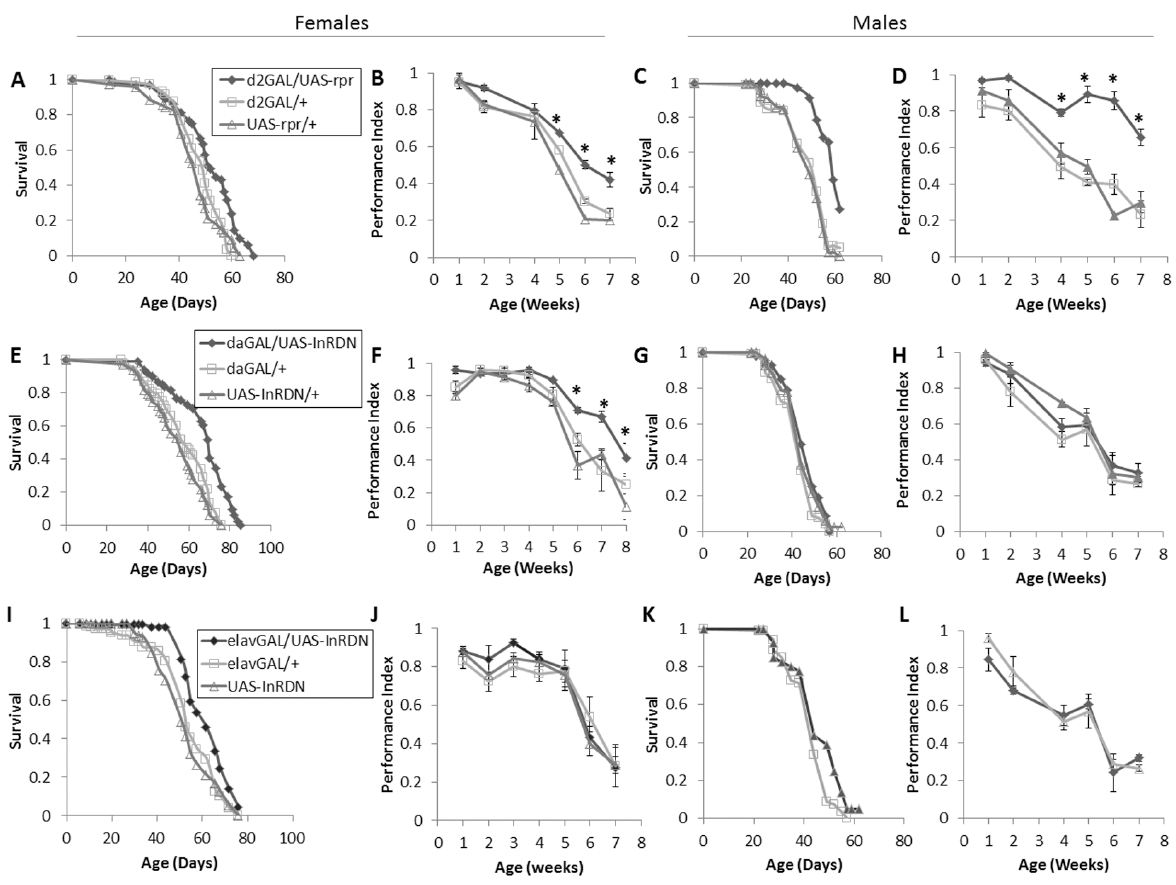
Fig 1. Survival and negative geotaxis senescence in female flies with ubiquitous (d2GAL/UAS-rpr and daGAL4/UAS-InR DN ) or neuron specific (elavGAL4/UAS-InR DN ) reductions in IIS. (A) Survival of d2GAL/UAS-rpr once mated female flies compared to d2GAL/+ and UAS-rpr/+ controls. Median lifespans and sample sizes were: d2GAL/UAS-rpr = 51 days, N = 71; d2GAL/+ = 49 days, N = 117; and UAS-rpr/+ = 48 days, N = 69. d2GAL/UAS-rpr showed an increased survival compared to both controls by log rank tests (P = 0.001). ( B ) Negative geotaxis performance index (PI) over the lifespan of d2GAL/UAS-rpr once mated female flies compared to d2GAL/+ and UAS-rpr/+ controls, N = 3 (groups of 15 flies) for each genotype. (C) Survival of d2GAL/ UAS-rpr male flies compared to d2GAL/+ and UAS-rpr/+ controls. Median lifespans and sample sizes were: d2GAL/UAS-rpr = 58 days, N = 70; d2GAL/+ = 47 days, N = 80; and UAS-rpr/+ = 50 days, N = 80. d2GAL/UAS-rpr showed an increased survival compared to both controls by log rank tests (P < 0.0001). ( D ) Negative geotaxis performance index (PI) over the lifespan of d2GAL/UAS-rpr male flies compared to d2GAL/+ and UAS-rpr/+ controls, N = 3 (groups of 15 flies) for each genotype. ( E ) Survival of daGAL4/UAS-InR DN once mated female flies compared to daGAL4/+ and UAS-InR DN /+ controls. Median lifespans and sample sizes were: daGAL4/UAS-InR DN = 70 days, N = 81; daGAL4/+ = 59 days, N = 84; and UAS-InR DN /+ = 56 days, N = 97. daGAL4/UAS-InR DN showed an increased survival compared to both controls (P < 0.0001). ( F ) Negative geotaxis performance index (PI) over the lifespan of daGAL4/UAS-InR DN once mated female flies compared to daGAL4/+ and UAS-InR DN /+ controls, N = 4 (groups of 15 flies) for each genotype. ( G ) Survival of daGAL4/UAS-InR DN male flies compared to daGAL4/+ and UAS-InR DN /+ controls. Median lifespans and sample sizes were: daGAL4/UAS-InR DN = 41 days, N = 80; daGAL4/+ = 41 days, N = 80; and UAS-InR DN /+ = 41 days, N = 80. ( H ) Negative geotaxis performance index (PI) over the lifespan of daGAL4/UAS-InR DN male flies compared to daGAL4/+ and UAS-InR DN /+ controls, N = 3 (groups of 15 flies) for each genotype. ( I ) Survival of elavGAL4/UAS-InR DN once mated female flies compared to elavGAL4/+ and UAS-InR DN /+ controls. Median lifespans and sample sizes were: elavGAL4/UAS-InR DN = 60 days, N = 71; elavGAL4/+ = 52 days, N = 84; and UAS-InR DN /+ = 47.5 days, N = 81. elavGAL4/UAS-InR DN showed an increased survival compared to both controls (P < 0.0001) ( J ) Negative geotaxis performance index (PI) over the lifespan of elavGAL4/UAS-InR DN once mated female flies compared to elavGAL4/+ and UAS-InR DN /+ controls, N = 3 (groups of 15 flies) for each genotype. ( K ) Survival of elavGAL4/UAS-InR DN male flies compared to elavGAL4/+ and UAS-InR DN /+ controls. Median lifespans and sample sizes were: elavGAL4/UAS-InR DN = 56 days, N = 105; elavGAL4/+ = 53 days, N = 89; and UAS-InR DN /+ = 56 days, N = 95. ( L ) Negative geotaxis performance index (PI) over the lifespan of elavGAL4/UAS-InR DN male flies compared to elavGAL4/+ and UAS-InR DN /+ controls, N = 3 (groups of 15 flies) for each genotype. Negative geotaxis data were analysed by two way ANOVA and age and genotype found to be the main effects (p < 0.05). Differences between genotypes at individual time points were analysed by one way ANOVA followed by post hoc means comparisons using Tukey HSD. * indicates significant difference between experimental group and both controls, p < 0.05.